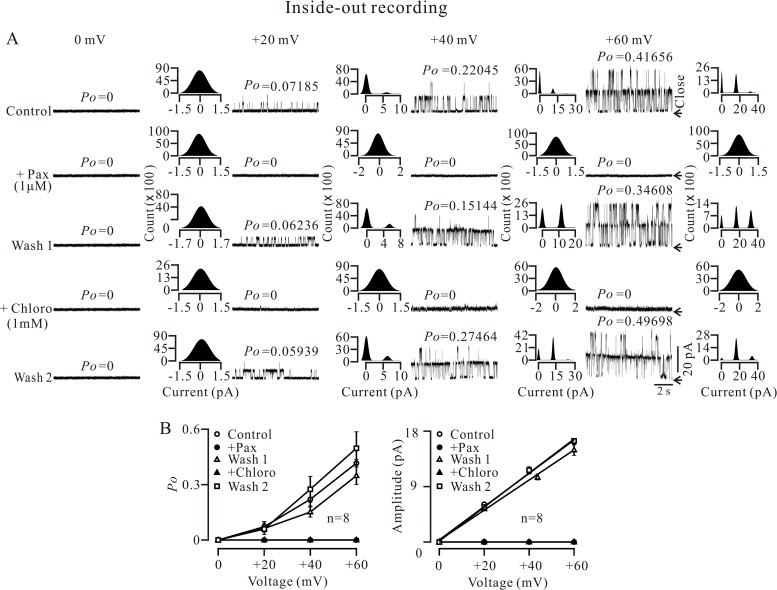
Intracellular chloro blocks single BK currents.(A) A cell was patched and an inside-out configuration was formed. The holding potential was 0 mV. Single channel currents were then recorded at 0, 20, 40, and 60 mV, which were blocked by 1μM paxilline (pax, another selective blocker of BKs), indicating that these currents were BK currents. After pax washout, the currents resumed and were abolished by 1 mM chloro (from the intracellular side). After washing out the chloro, the currents re-occurred. The closed state is indicated by arrows. The Po values were calculated and presented above the traces. All-point histograms were constructed and fitted with the Gaussian distribution function. The amplitudes of single channel currents were then obtained. (B) Based on the values from 8 experiments, the relationships between the Po and voltage, and amplitude and voltage were plotted. These data indicate that chloro blocks BKs completely from the intracellular side.